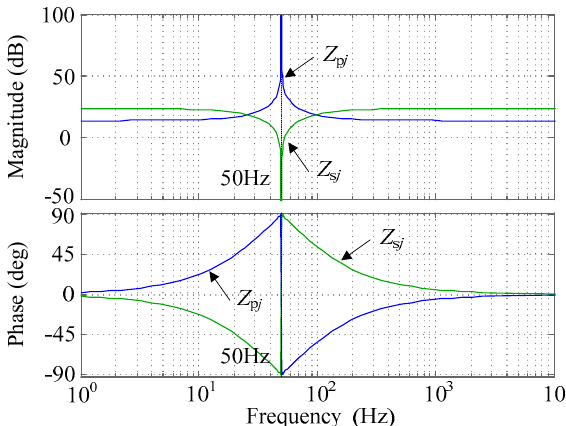
Figure 8. The Bode diagrams of parallel virtual impedance Z p j and series virtual impedance Z s j . The Bode diagrams of the inverter self-impedance Z o j , parallel virtual impedance Z p j ,